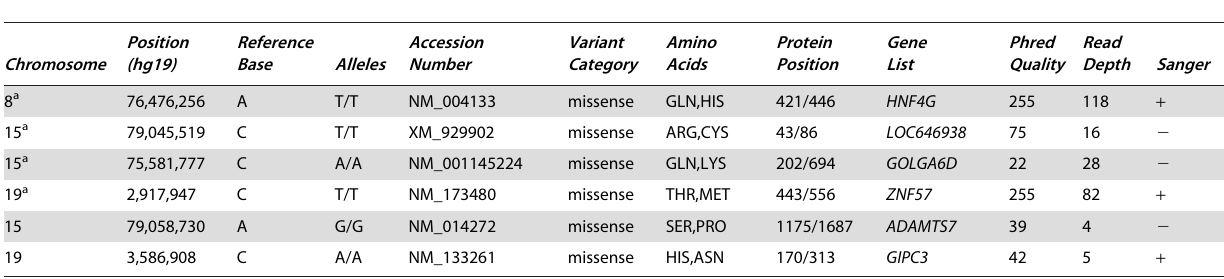
Table 2. Novel missense, nonsense, splice site, and frameshift variants in top five autozygous regions.